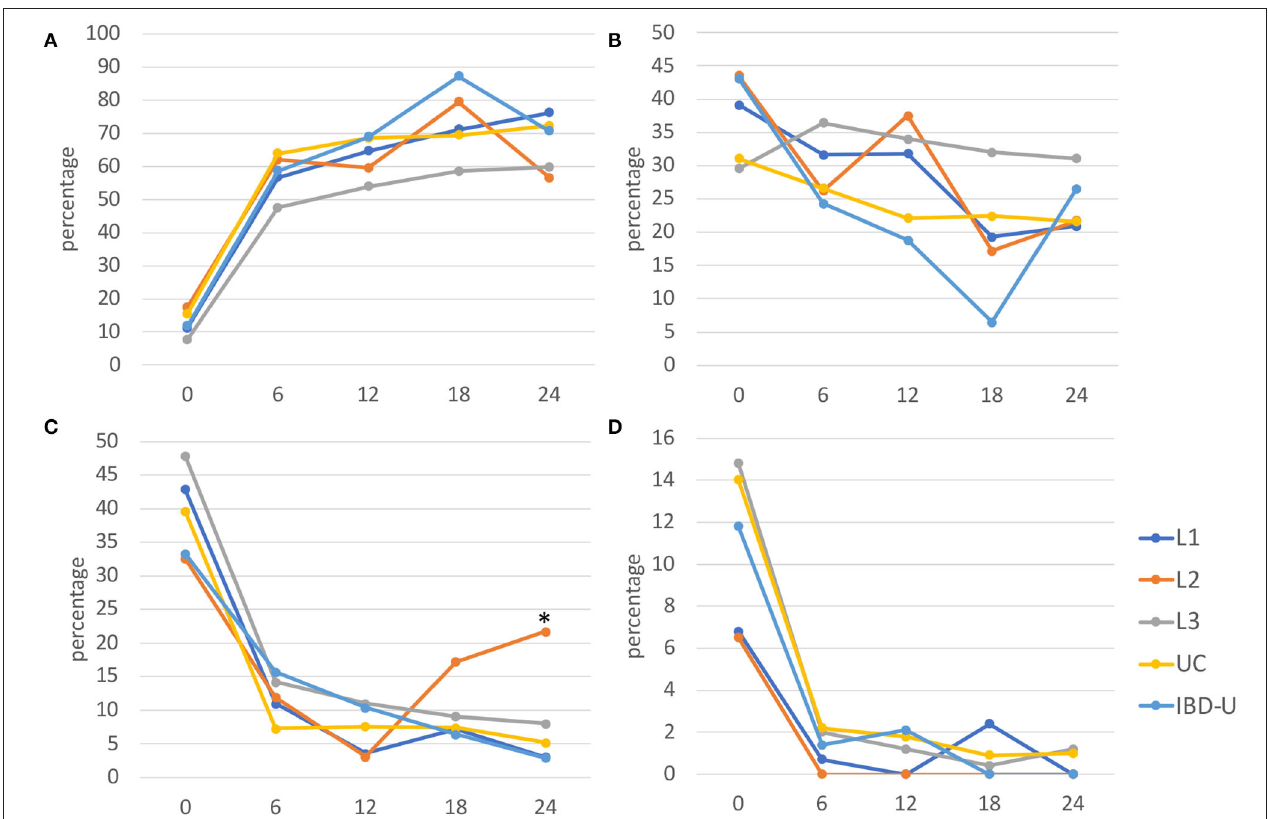
FIGURE 2 | Disease activity from diagnosis to 24 months after. Disease activity was evaluated at diagnosis (0), and for every 6 months ( ± 3 months) of follow-up for each subgroup using the physician global assessment (PGA) and presented as percentage for (A) remission, (B) mild, (C) moderate, and (D) severe activities (L1, blue; L2, orange; L3, gray; UC, yellow; IBD-U, light blue). Significant differences (* p < 0.05) were found for moderate disease activity in L2 after 24 months compared with the other subgroups,